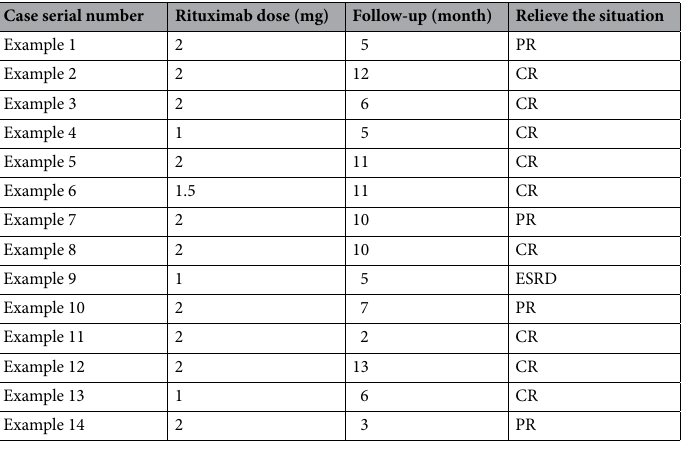
Table 2. Treatment of 14 patients with primary FSGS. PR Partial remission, CR Complete remission, ESRD End-stage renal